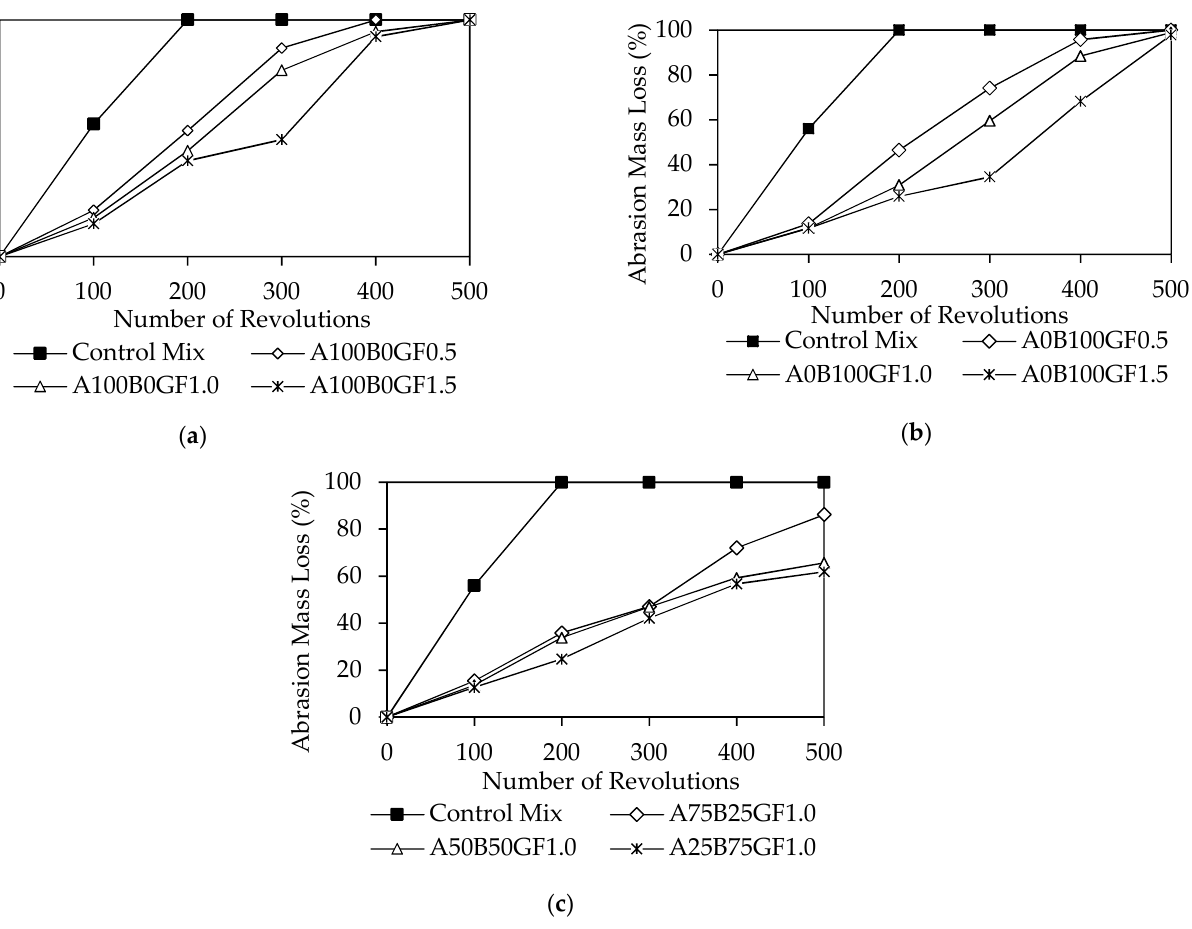
Figure 15. Relationship between abrasion resistance and 28-day compressive strength.